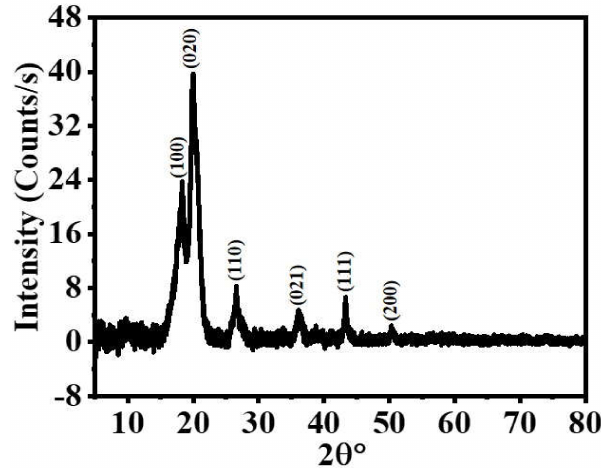
Figure 4. XRD results of Ni 0.3 Cu 0.7 /PVDF-HFP NF membranes.